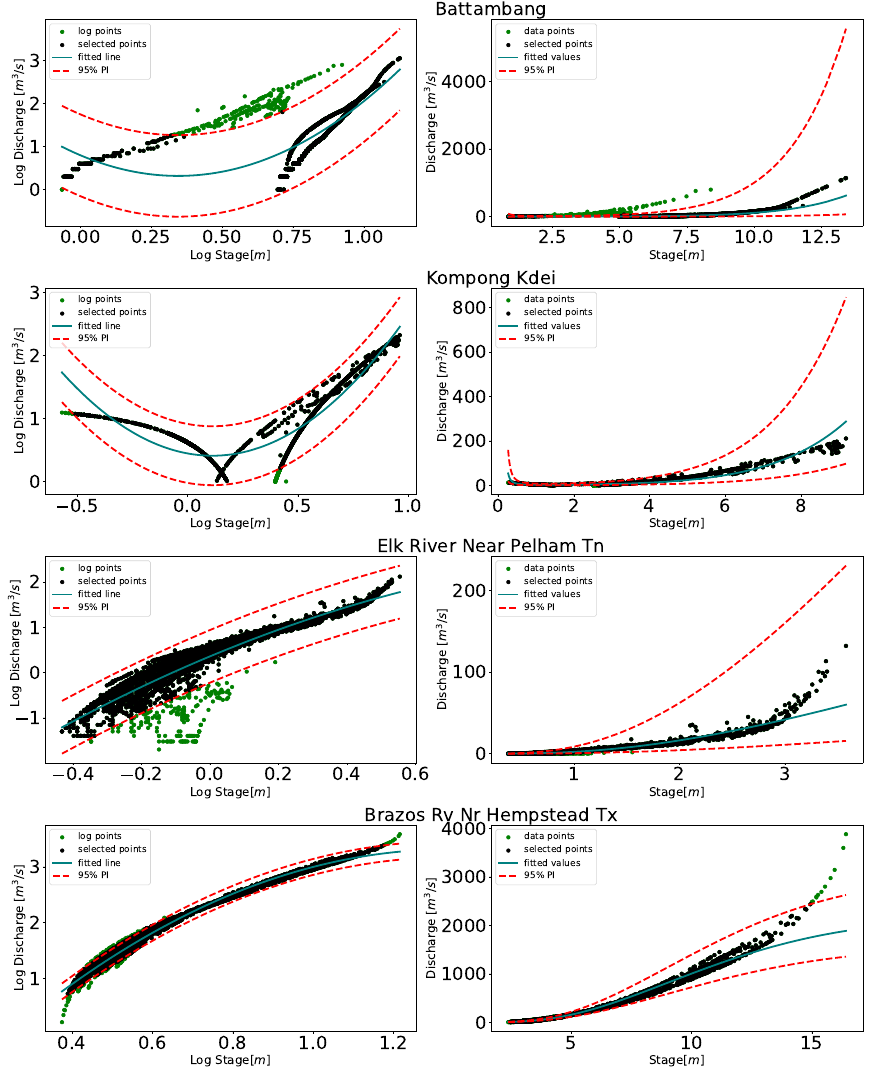
Figure 9. The figure shows the result of applying the 95% Prediction Interval with second-degree log stage-discharge relation, while most stations adhered to this relation, some (for example, Brazos River near Hempstead in Texas) did not strictly followed; a higher order may be